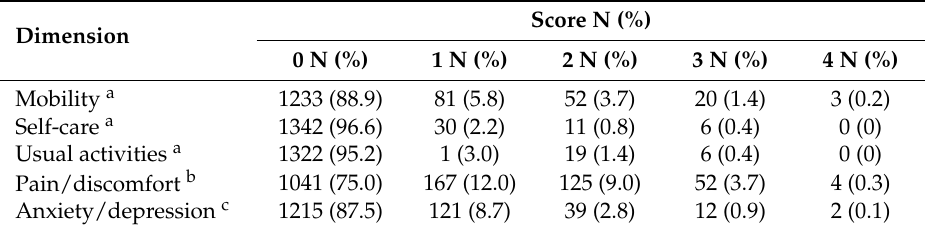
Table 4. Health status of the park users evaluated through the EQ5D-5L questionnaire (N = 1392). Score N (%) Dimension 0 N (%) 1 N (%) 2 N (%) 3 N (%) 4 N (%) Mobility a 1233 (88.9) 81 (5.8) 52 (3.7) 20 (1.4) 3 (0.2) Self-care a 1342 (96.6) 30 (2.2) 11 (0.8) 6 (0.4) 0 (0) Usual activities a 1322 (95.2) 1 (3.0) 19 (1.4) 6 (0.4) 0 (0) Pain/discomfort b 1041 (75.0) 167 (12.0) 125 (9.0) 52 (3.7) 4 (0.3) Anxiety/depression c 1215 (87.5) 121 (8.7) 39 (2.8) 12 (0.9) 2 (0.1)